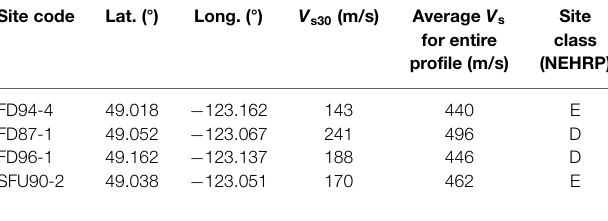
TABLE 3 | The location of the four sites in the Fraser River Delta.